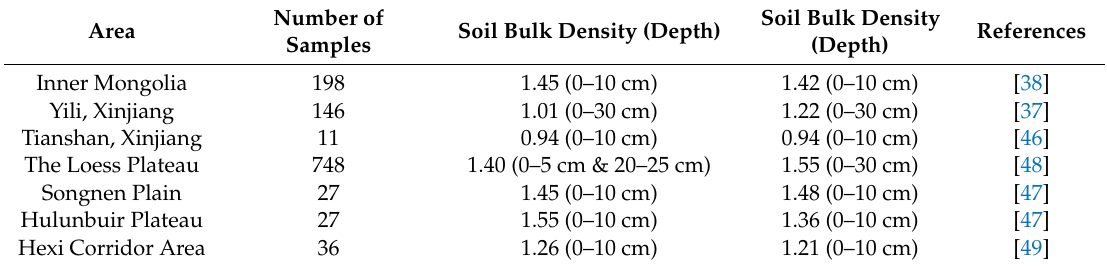
Table 4. Comparison of soil bulk density research results in di ff erent